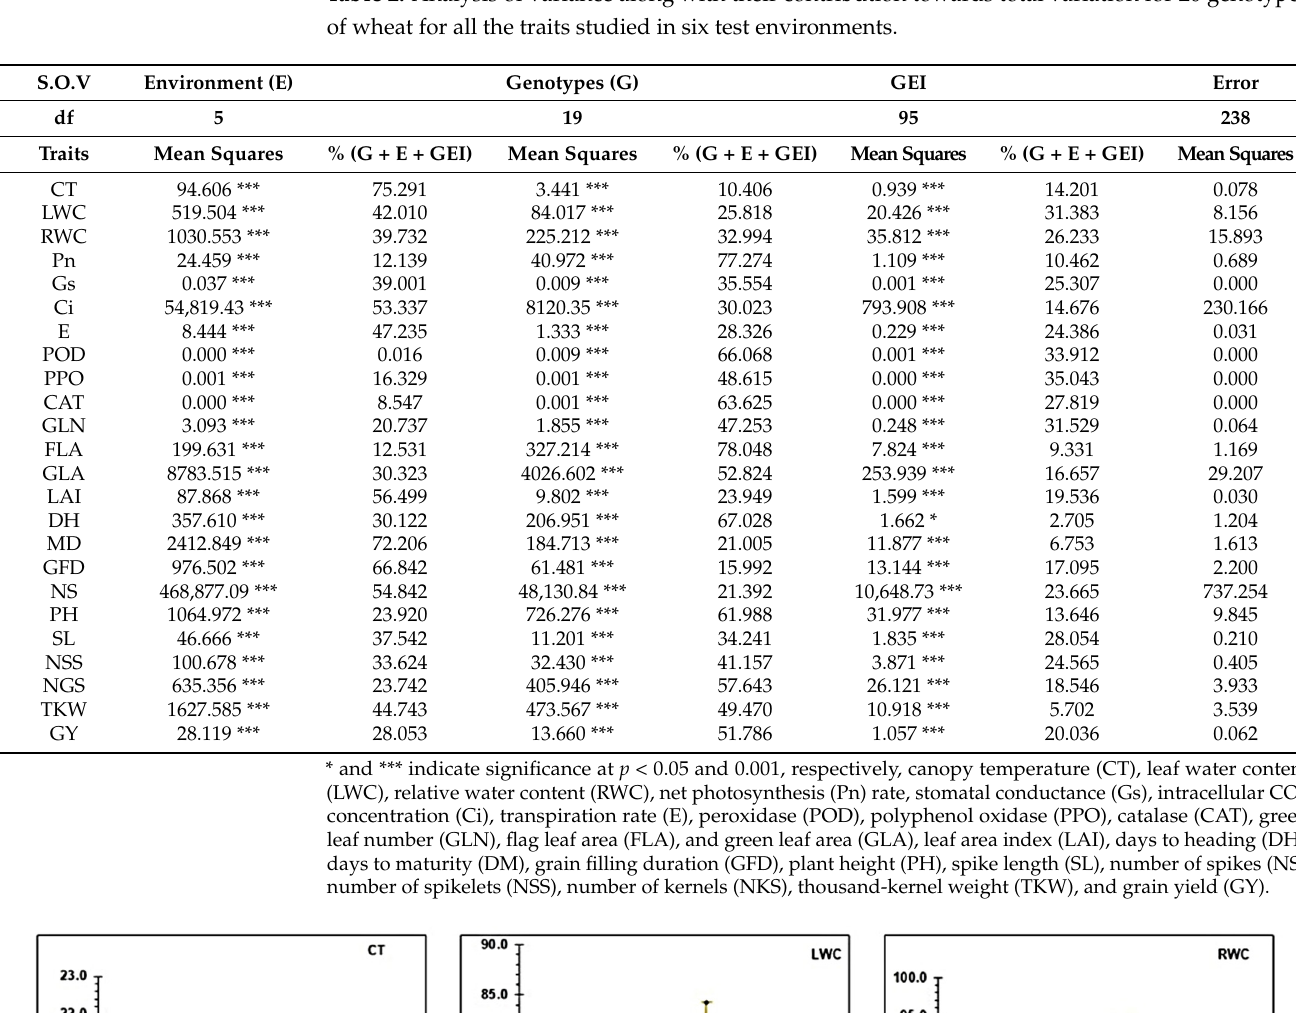
Table 2. Analysis of variance along with their contribution towards total variation for 20 genotypes of wheat for all the traits studied in six test environments.